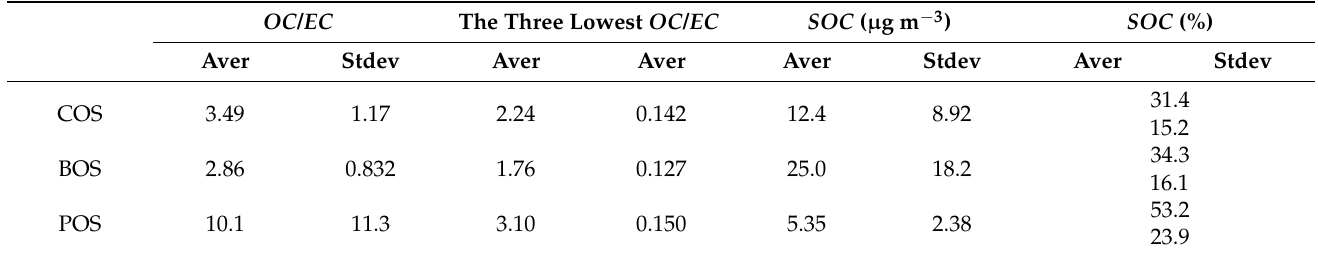
Table 2. Statistical descriptions of the OC/EC ratios and SOC in PM 2.5 collected at COS, BOS, and